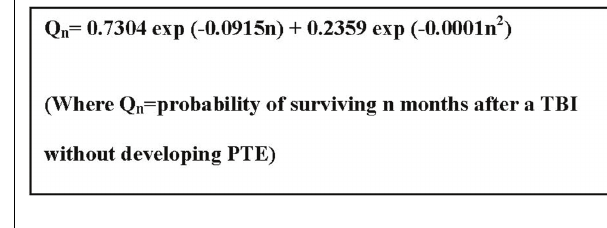
FIGURE 1 | Predictive formula for the risk of developing PTE.